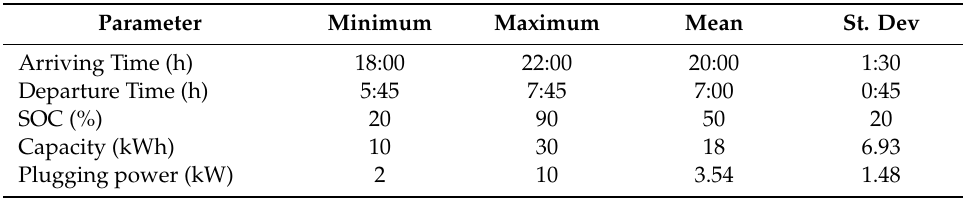
Table 3. Parameters for the fleet with 100 EVs.